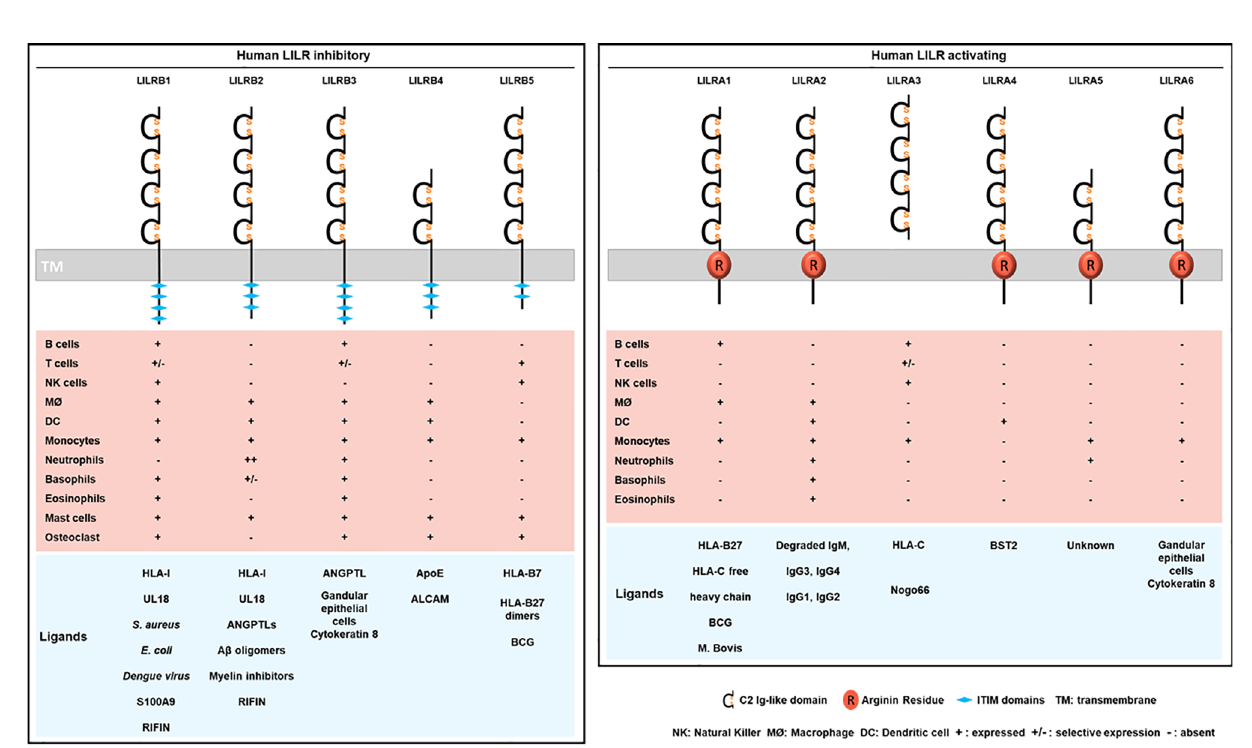
FIGURE 2 | Structure, cellular distribution and ligands of the inhibitory LILRB (left) and activating LILRA (right). LILRB1-B5 are inhibitory LILRs that contain ITIM domains in their cytoplasmic part (left). LILRA1, LILRA2, LILRA4, LILRA5, LILRA6 are activating receptors with a short cytoplasmic tail and an arginine residue (in red) in their transmembrane portion (right). LILRA3 is soluble owing to the lack of a transmembrane and a cytoplasmic domain. Below is represented the LILR distribution on immune cell populations (MØ, macrophages). The different known ligands are shown in